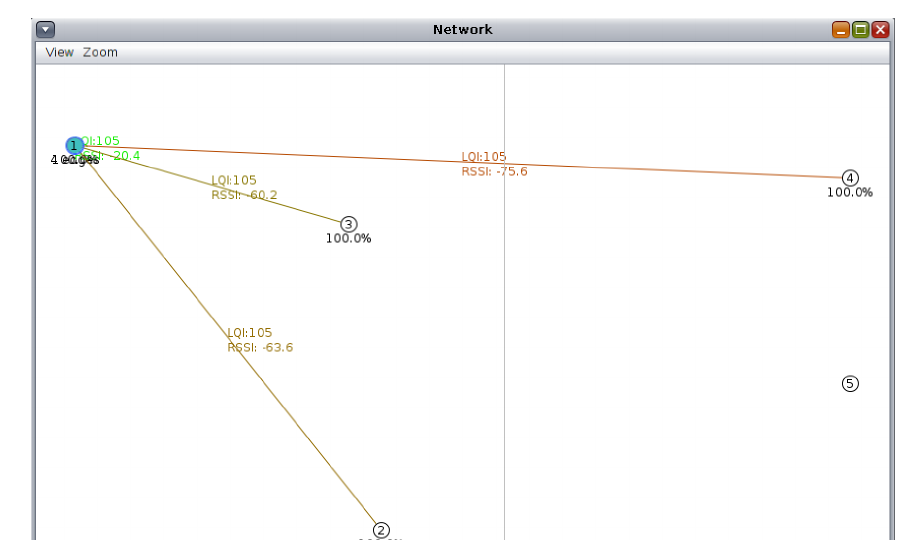
Figure 5. MRM model simulation.